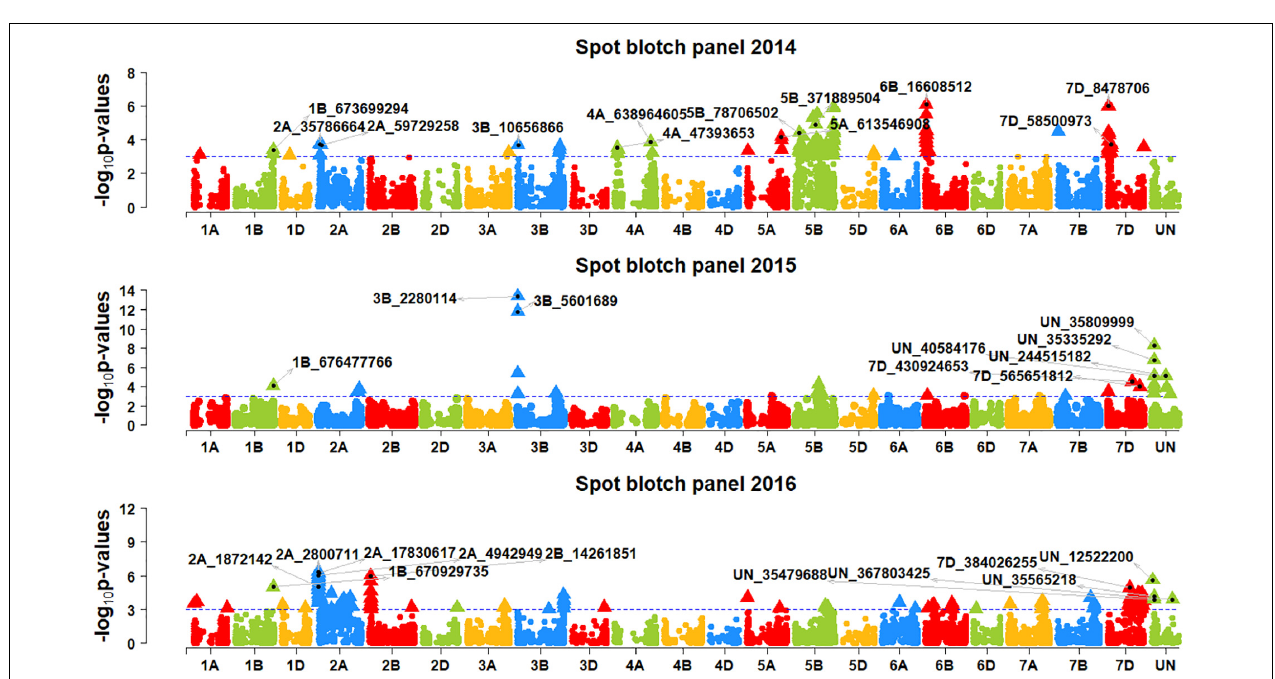
FIGURE 1 | Distribution of the spot blotch relative area under the disease progress curve (rAUDPC) values in panel 2014 (904 lines), panel 2015 (949 lines), panel 2016 (990 lines), panel 2017 (1,011 lines), panel 2018 (962 lines), panel 2019 (943 lines), and panel 2020 (977 lines) during the 2014, 2015, 2016, 2017, 2018, 2019, and 2020 evaluations, respectively.